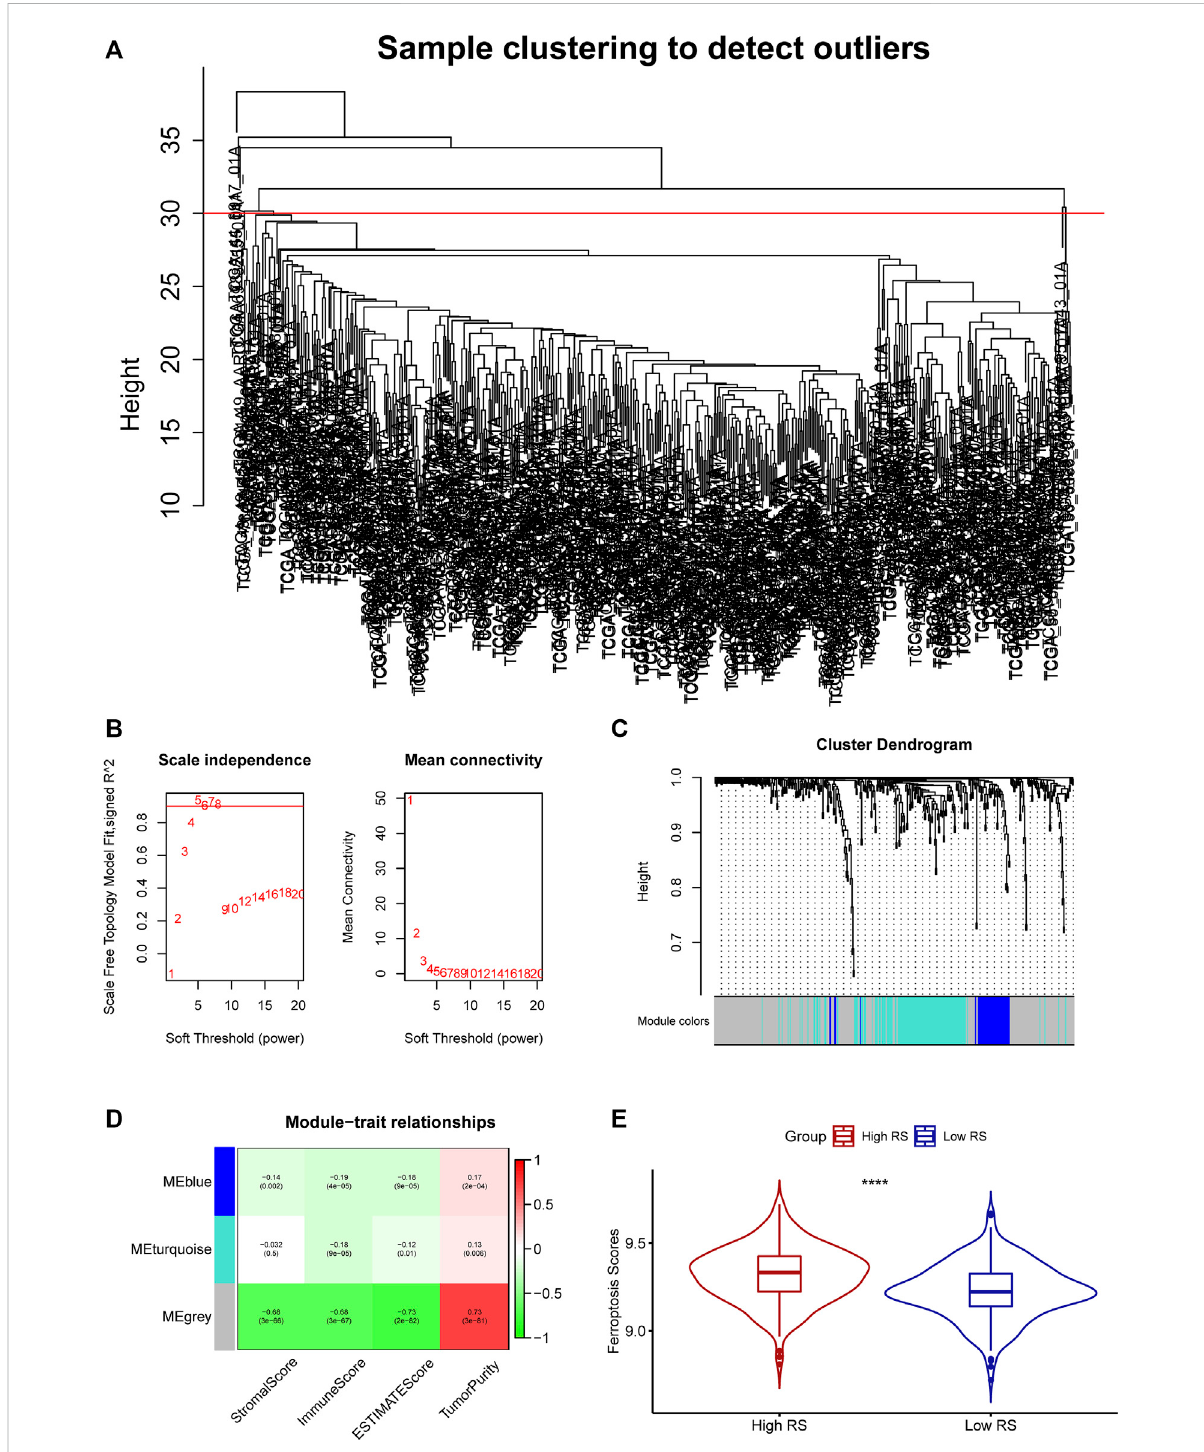
FIGURE 1 (A) Clustering of samples and removal of outliers. (B) Analysis of network topology for various soft-thresholding powers. (C) The cluster dendrogramofgenesofLUADpatients.Eachbranchinthe fi gurerepresentsonegene,andeverycolorbelowrepresentsoneco-expressionmodule. (D) Correlation between thegenemoduleandclinicalcharacteristics,includingstromal score,immune score,ESTIMATE score,andtumorpurity. (E) The ferroptosis-related score difference between the two